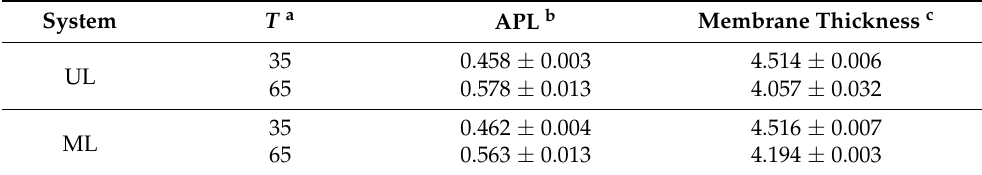
Table 2. Area per lipid (APL) and membrane thickness of DPPS + 5% DPPG unilamellar (UL) and multilamellar (ML) systems at 35 and 65 ◦ C determined